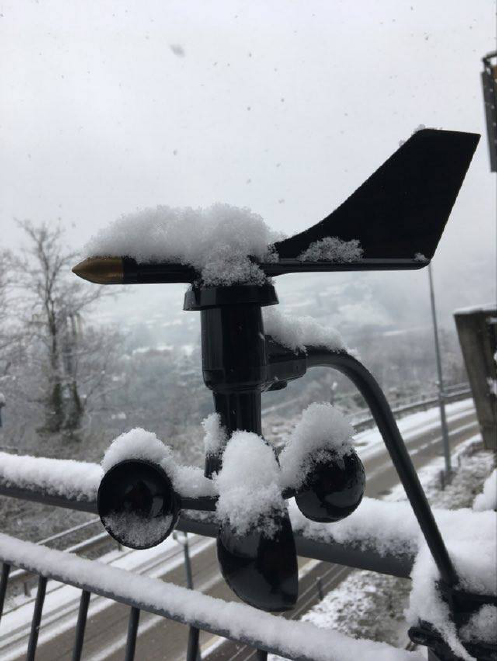
Figure 6. Anemometer deployed in the outdoor environment. More in detail, a transmission cycle consists of an active phase, a transmission phase, and a reception phase, all measured using the Otii device. One transmission cycle took on average 6000 ms. First, the weather station switches to the active state from the sleep mode. Then, it transmits the data, waits for data reception, and, finally, upon data reception, switches back to the sleep mode. In the Otii software, a specific data transmission teleme- try chuck was selected to get measures in terms of maximum current, average current, and energy consumption during that data transmission. The weather station operates in the active state most of the time during the transmission cycle (i.e., 5690 ms) absorbing, on average, 4.05 mA of current. There is a spike in the current values with a peak of 126 mA, with an average current absorption of 124 mA during the data transmission that has a short duration of 60 ms. The average current absorbed during the data reception phase is 15 mA, lasting the latter more than four times the duration of the transmission one (i.e., 250 ms). The device remains in sleep mode for the remaining time, absorbing negligible currents (i.e., 273 µ